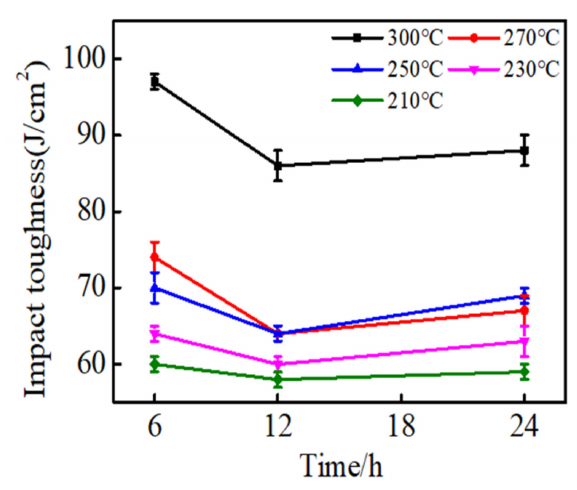
Figure 8. Impact toughness under different isothermal processes.